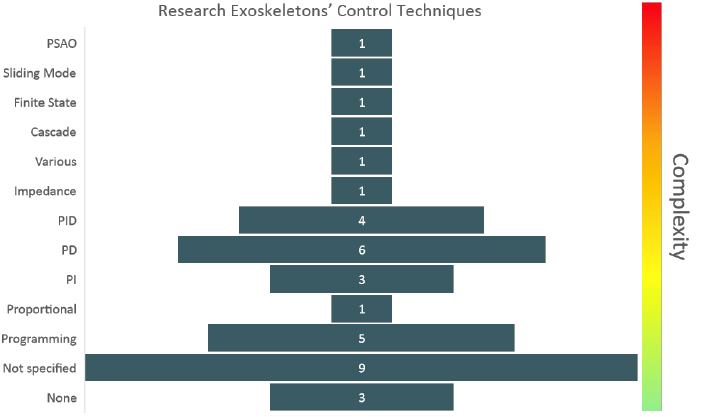
Figure 12. This figure portrays the control techniques of the exoskeletons in the research phase and distributes the techniques by the